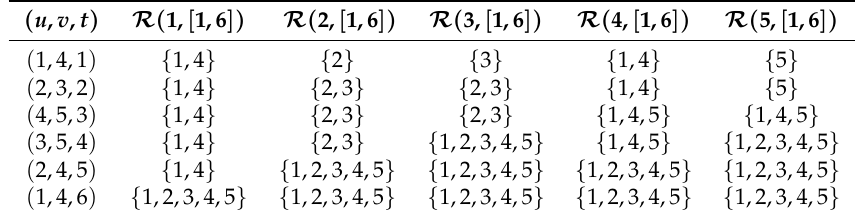
Table 1. Evolution of the reverse temporal cones for the temporal graph of Figure 2 (in which all edges are